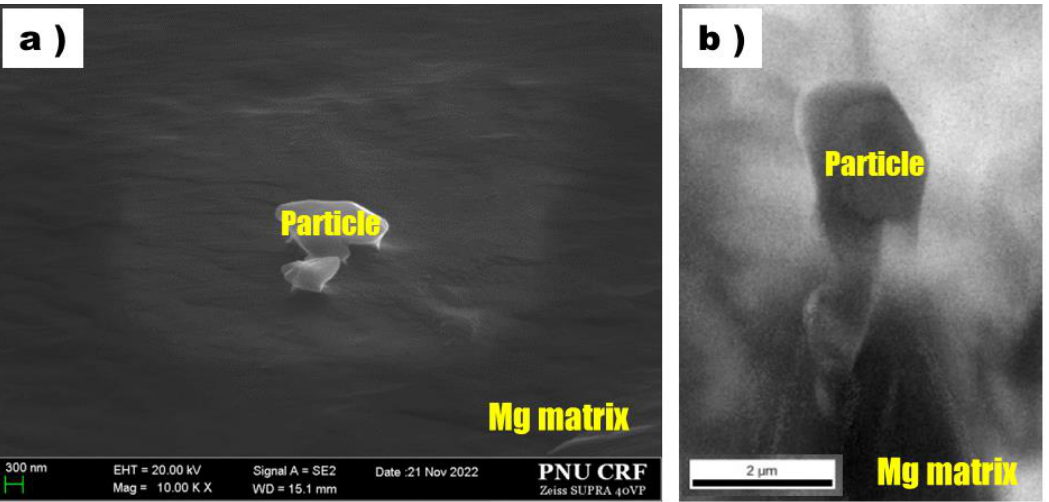
Figure 6. Particle on high purity AZ91 alloy ribbon samples observed using EBSD: ( a ) SEM image and ( b ) IQ map.